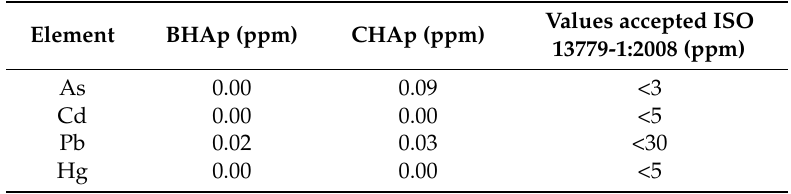
Table 3. Heavy elements content of BHAp and CHAp samples measured by ICP-OES.